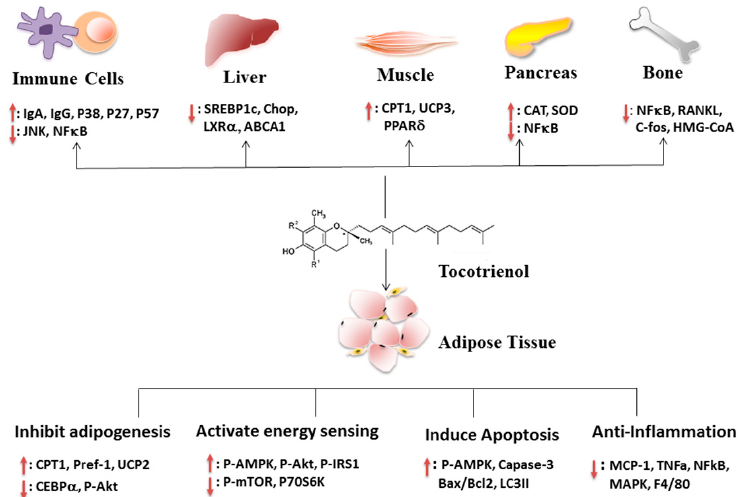
Figure 1. Mechanisms for the effect of tocotrienols (T3s) on obesity and obesity-associated complications. Briefly, T3s accumulate in adipose tissue and attenuate obesity mainly by: (1) inhibiting adipogenesis in adipose stem cells; (2) activating energy sensing in differentiating or maturate adipocytes; (3) enhancing apoptosis in preadipocytes; and (4) suppressing MAPK, NF κ B and inflammatory cytokine secretion in inflamed adipocytes. In addition, T3s also exert their anti-obesity effects by reducing inflammation in immune cells, pancreas and bone, suppressing fatty acid and cholesterol synthesis in the liver and enhancing energy expenditure and antioxidant activity in muscle and pancreas.